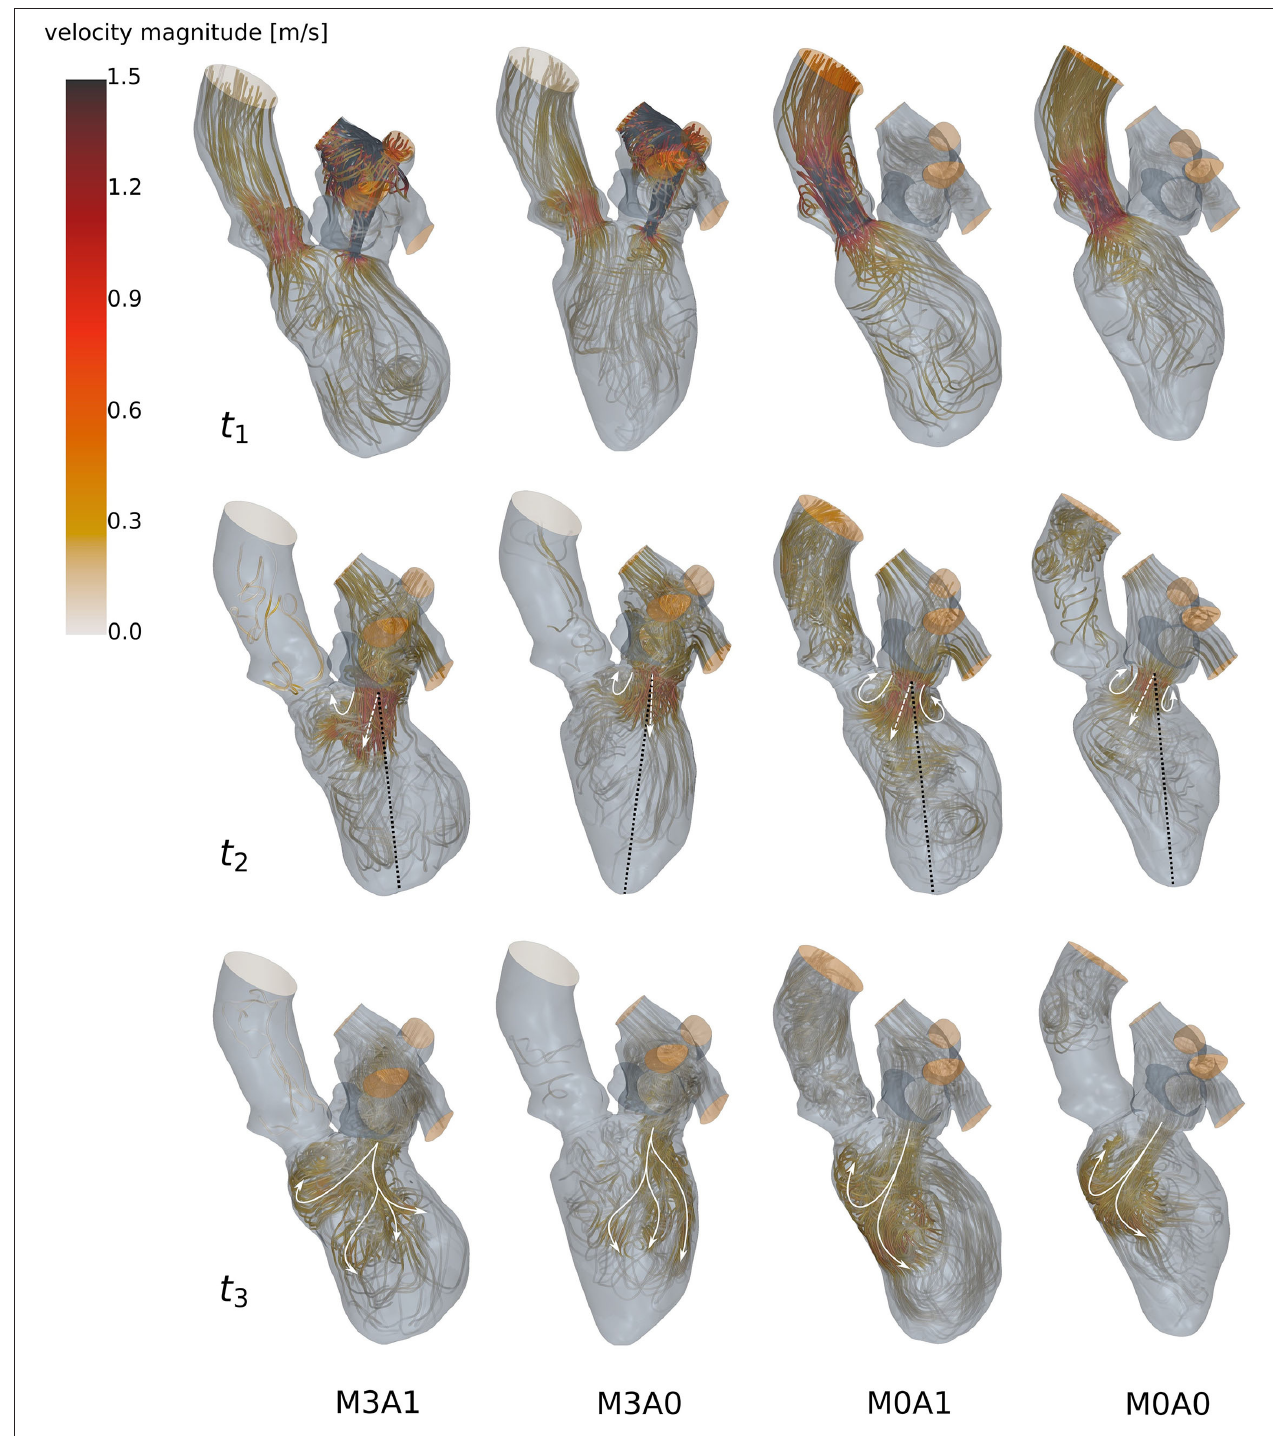
FIGURE 6 | Streamlines of all four cases (left to right: M3A1, M3A0, M0A1, and M0A0) at t 1 : peak systole (top), t 2 : peak E-wave (mid), and t 3 : diastasis (bottom) of the seventh cycle. The white arrow, the dashed white arrow, and the dotted black line at t 2 qualitatively show the vortex formation, the orientation of the E-wave jet, and the ventricular axis from MV center to apex. The white arrows at t 3 schematically display the path of the E-wave jet. At low velocity regions, streamlines are made transparent and velocities above 1.5 m/s are clipped.